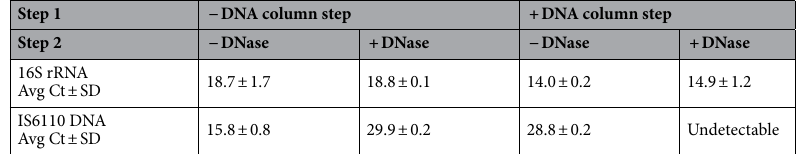
Table 2. The combination of a two-step DNA removal process (DNA column and DNase digestion) removes more Mtb DNA than either alone. A secondary benefit of DNA removal prior to RNA purification is improved recovery of Mtb 16S rRNA. Average cycle threshold values from three replicates for each condition using a patient sputum sample are presented; Avg, average; SD, standard